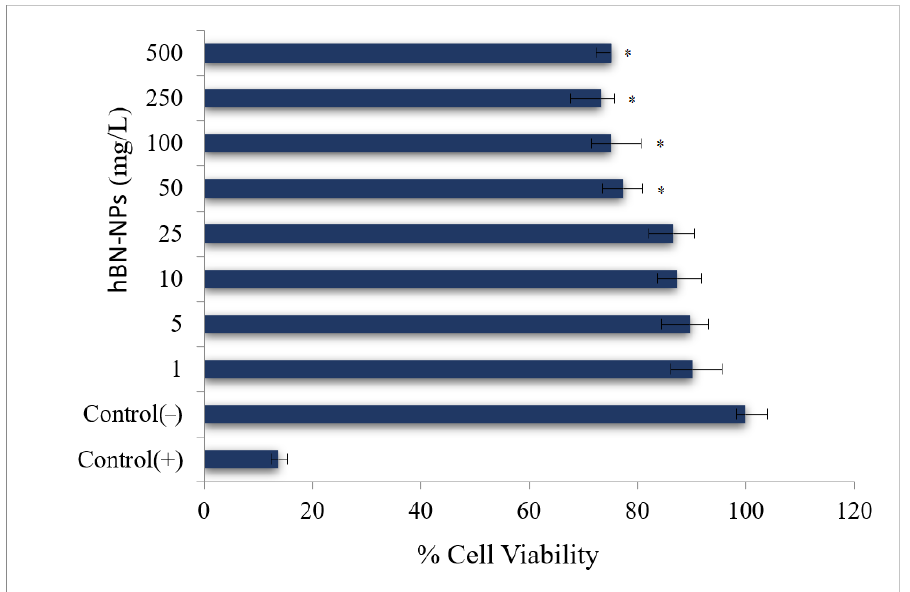
Figure 5. Cell viability (MTT assay) in differentiated SH-SY5Y cell cultures maintained 48 h in the presence of hBN-NPs. (Control ( − ): Cells without hBN-NPs; Control (+): Cell treated with Triton-X). * Symbol presents significant differences at the p < 0.05 level from the control group.